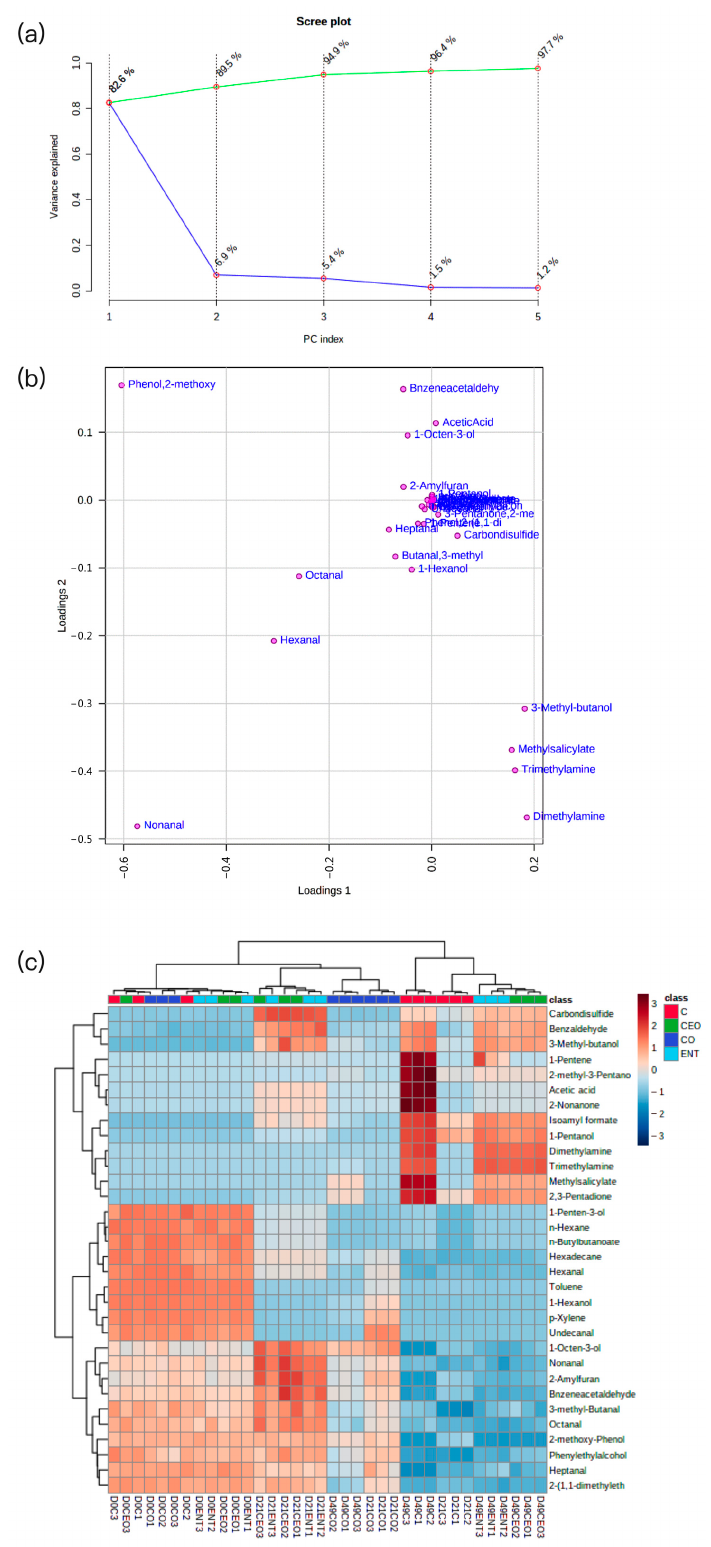
Figure 7. Principal component analysis ( a ), principal components contribute to variance ( b ) and heat-map analysis ( c ) based on volatile-compound profile of liquid-smoked salmon fillets treated with nanoemulsions containing enterocin Gr17 alone (ENT-NE), cinnamaldehyde alone (CEO-NE), enterocin Gr17 and cinnamaldehyde (CO-NE) and no enterocin Gr17/cinnamaldehyde (Control) during storage at 4 ◦ C on 0th, 21st, 49th